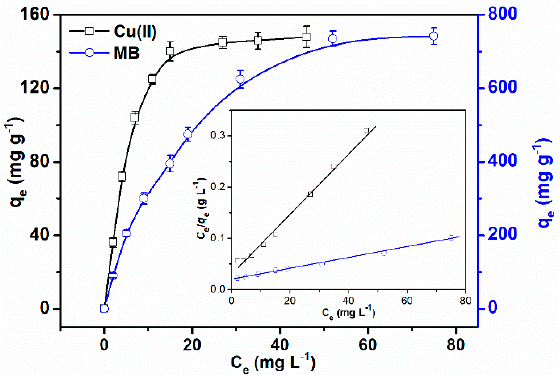
Figure 7. Adsorption isotherm curve of the adsorption of MB and Cu(II) (inset, Langmuir isotherm plots).